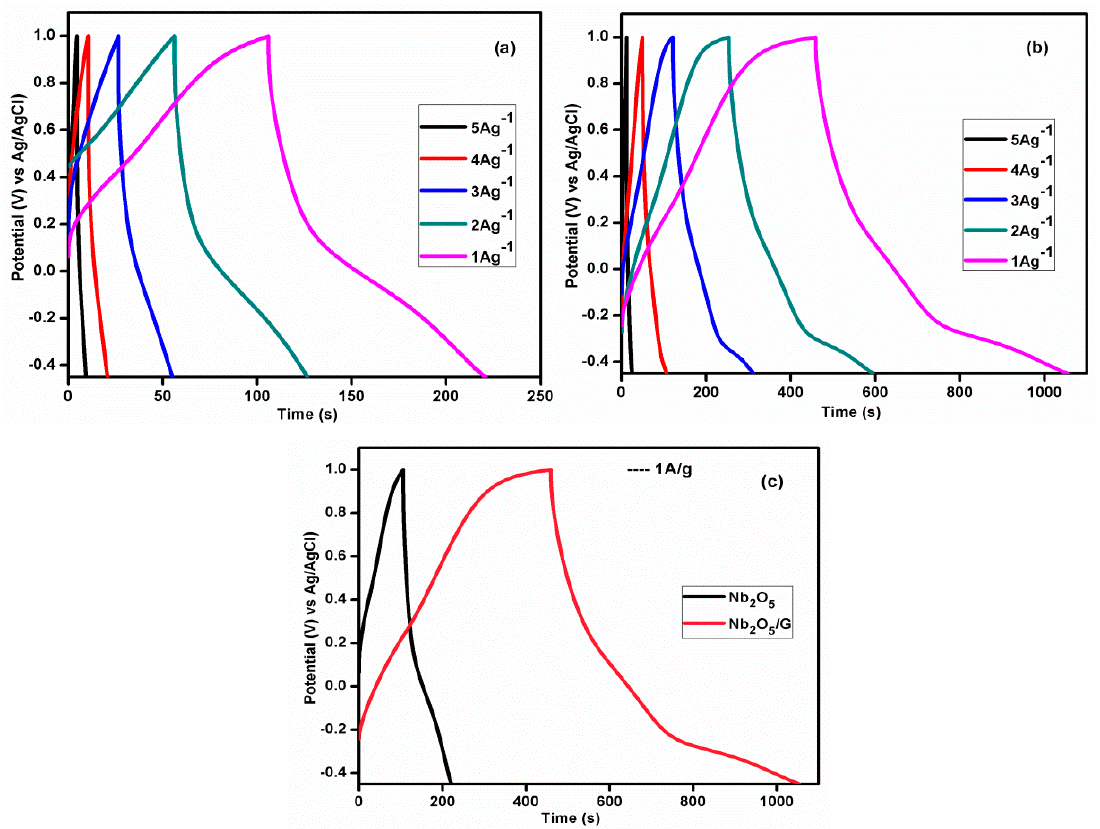
Figure 10. Charge-discharge profile of ( a ) Nb 2 O 5 and ( b ) Nb 2 O 5 / G nanocomposites. ( c ) Comparison charge-discharge profile at a current density of 1 Ag − 1 .